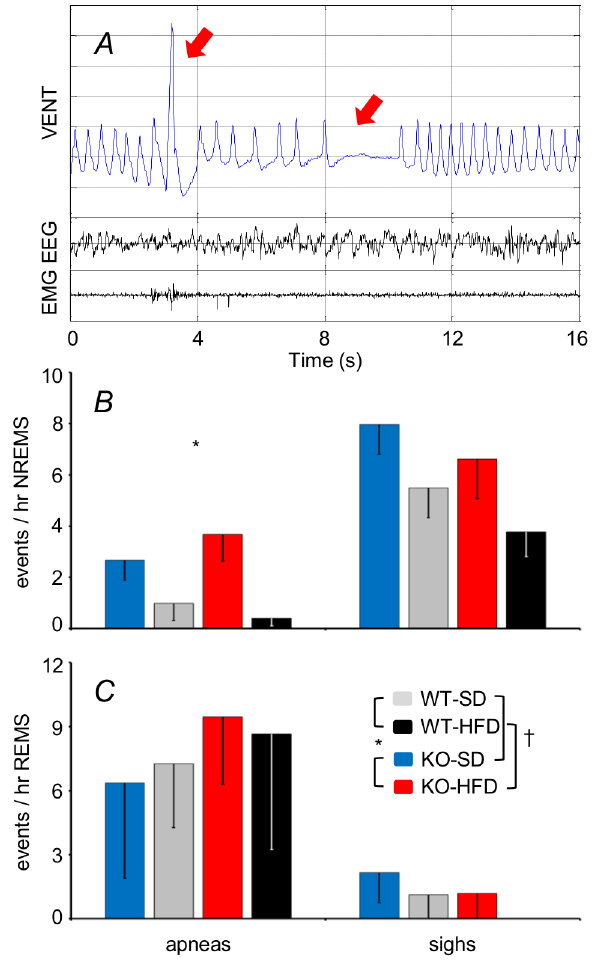
Figure 7. Sleep apneas and sighs. Panel A shows representative recordings of the raw plethysmograph signal (VENT), the electroen- cephalogram (EEG), and the neck muscle electromyogram (EMG) during NREMS for a KO mouse fed a HFD. The red arrows indicate a sigh (A; left) followed by a brief apnea (A, right). Panels B and C show the frequency of apneas (left) and sighs (right) per hour NREMS and REMS, respectively. Data are means 6 SEM for KO mice fed a SD (n=4) or a HFD (n=8) and for WT mice fed a SD (n=7) or a HFD (n=5). For abbreviations and symbols see Figures 1 and 3.